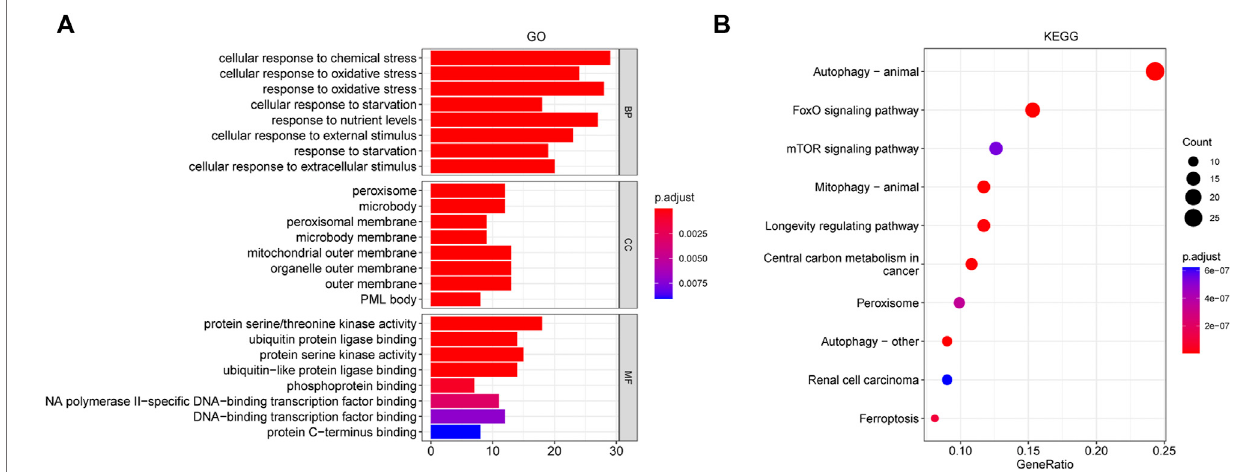
FIGURE 4 | GO and KEGG analysis for the whole ALS- related genes of brown and blue modules derived from WGCNA. (A) GO pathway analysis, including BP, CC,andMF. (B) Top10resultsofKEGGpathwayenrichmentanalysis.Thecolorrepresentstheadjusted p value,andthesizeofthedotsandbarrepresentsthenumber of the genes. Abbreviations: GO, gene ontology; KEGG, Kyoto encyclopedia of genes and genomes; WGCNA, weighted gene correlation network analysis; BP, biological process; CC, cellular component; MF, molecular